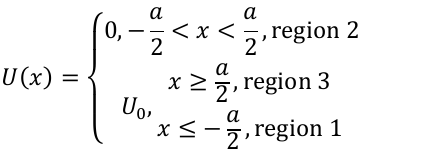
Fig. 2 . The most basic one-dimensional potential well with finite walls.